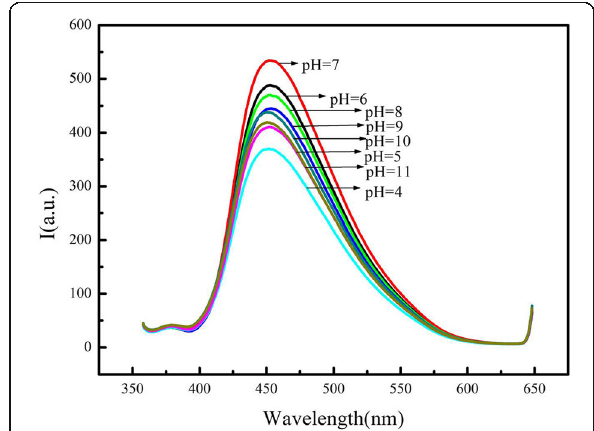
Fig. 4 The effect of pH to the fluorescence of the CdSe QDs/g-C 3 N 4 nanosheets